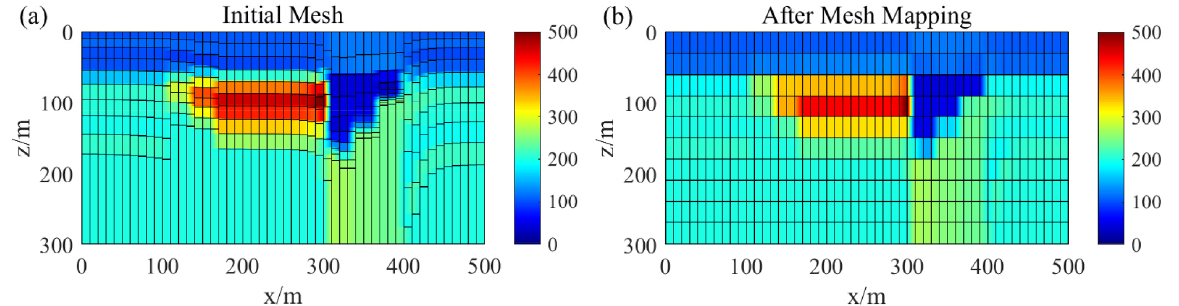
Figure 6. Comparison between the models before and after the mesh mapping method in the two- dimensional case: ( a ) initial model; ( b ) mesh-mapped model. two-dimensional case: ( a ) initial model; ( b ) mesh-mapped